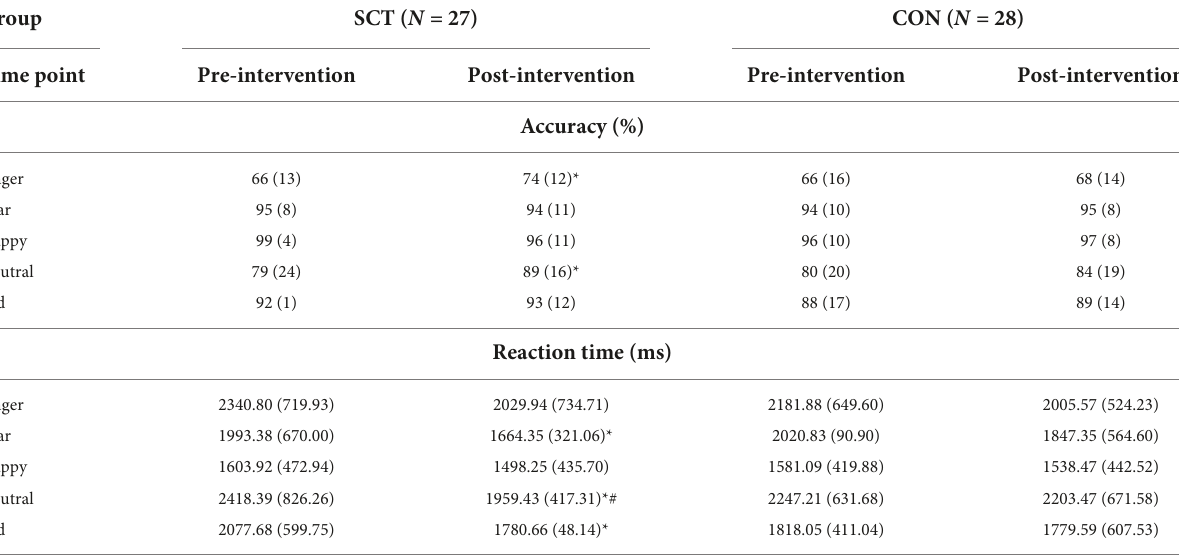
TABLE 5 Pre- and post-training accuracy (% correct) and Reaction Time (ms) for each